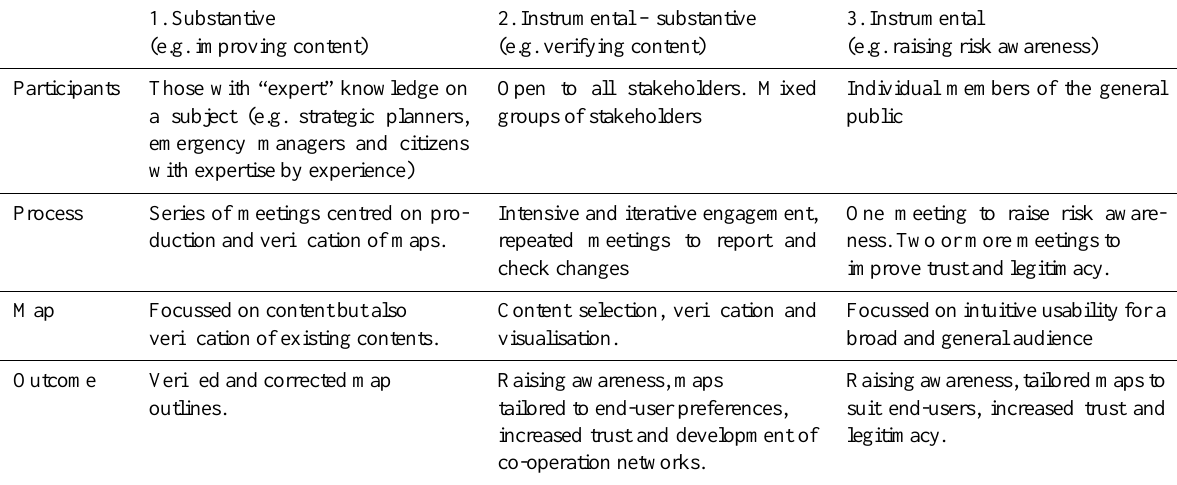
Table 2. Recommendations for participatory processes for different